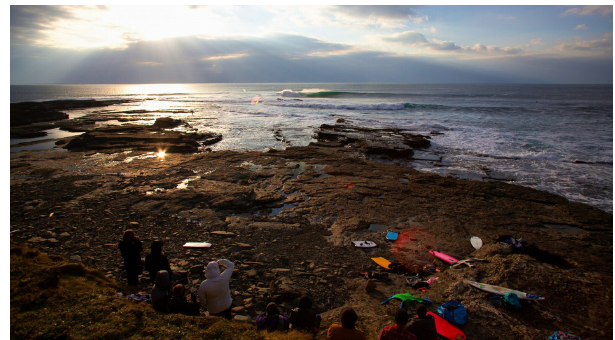
Figure 21. Sunset at Bumbaloids, Co. Clare (Craig, b). Table 6. The number of rogue waves and large waves recorded for buoys M2–M5 between March 2011 and June